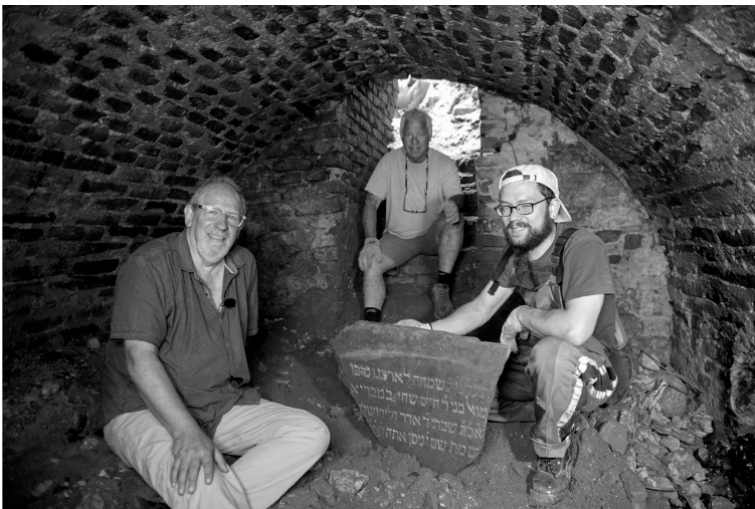
Figure 10. Discovery of the inscribed slab in the cellar below the bimah . Photo: Löic Salfati, the Vilna Synagogue and Shulhoyf Research Project. Used with permission.